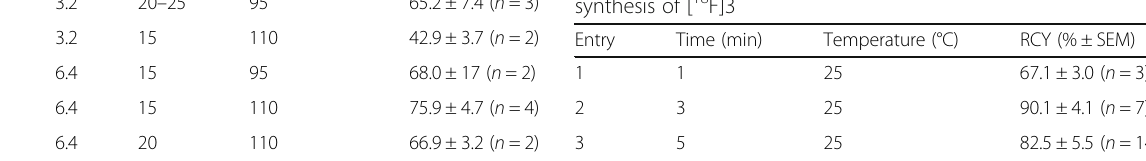
Table 4 N.i. RCY TLC monitoring at different time points for